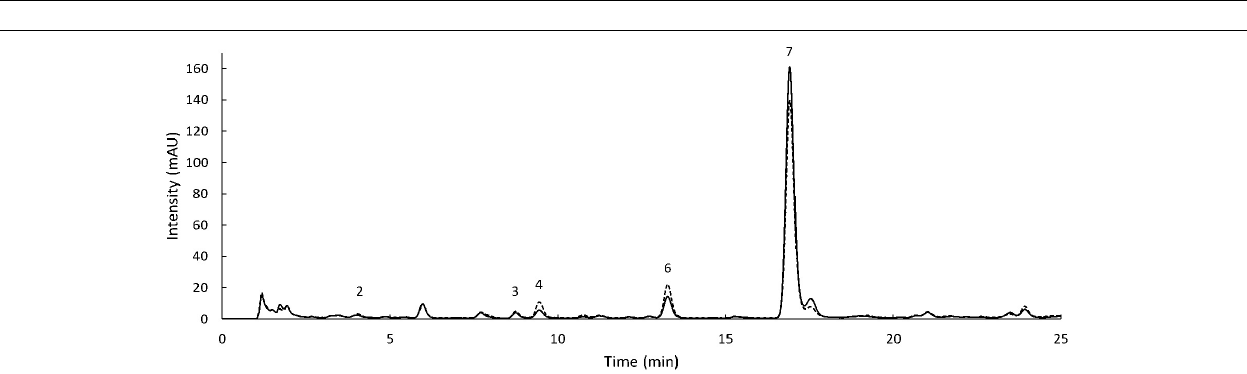
FIGURE 6 | HPLC chromatogram of the bound phenolic acids extracted from Kalatur (solid line) and Huggo (dash line) was recorded at 268 nm. 2: protocatechuic acid, 3: vanillic acid, 4: caffeic acid, 5: syringic acid, 6: P -coumaric acid, and 7: ferulic acid. Injection volume: 10 µ l.